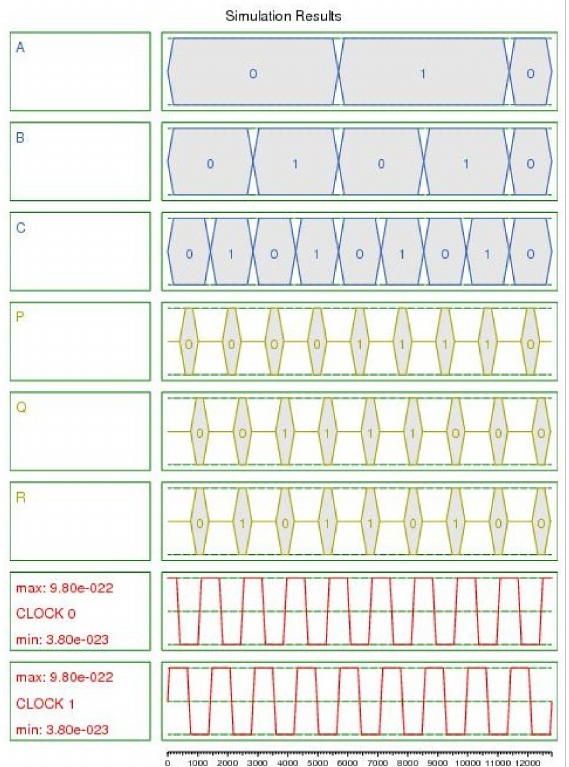
Figure 9. Simulation outcomes of the proposed double Feynman